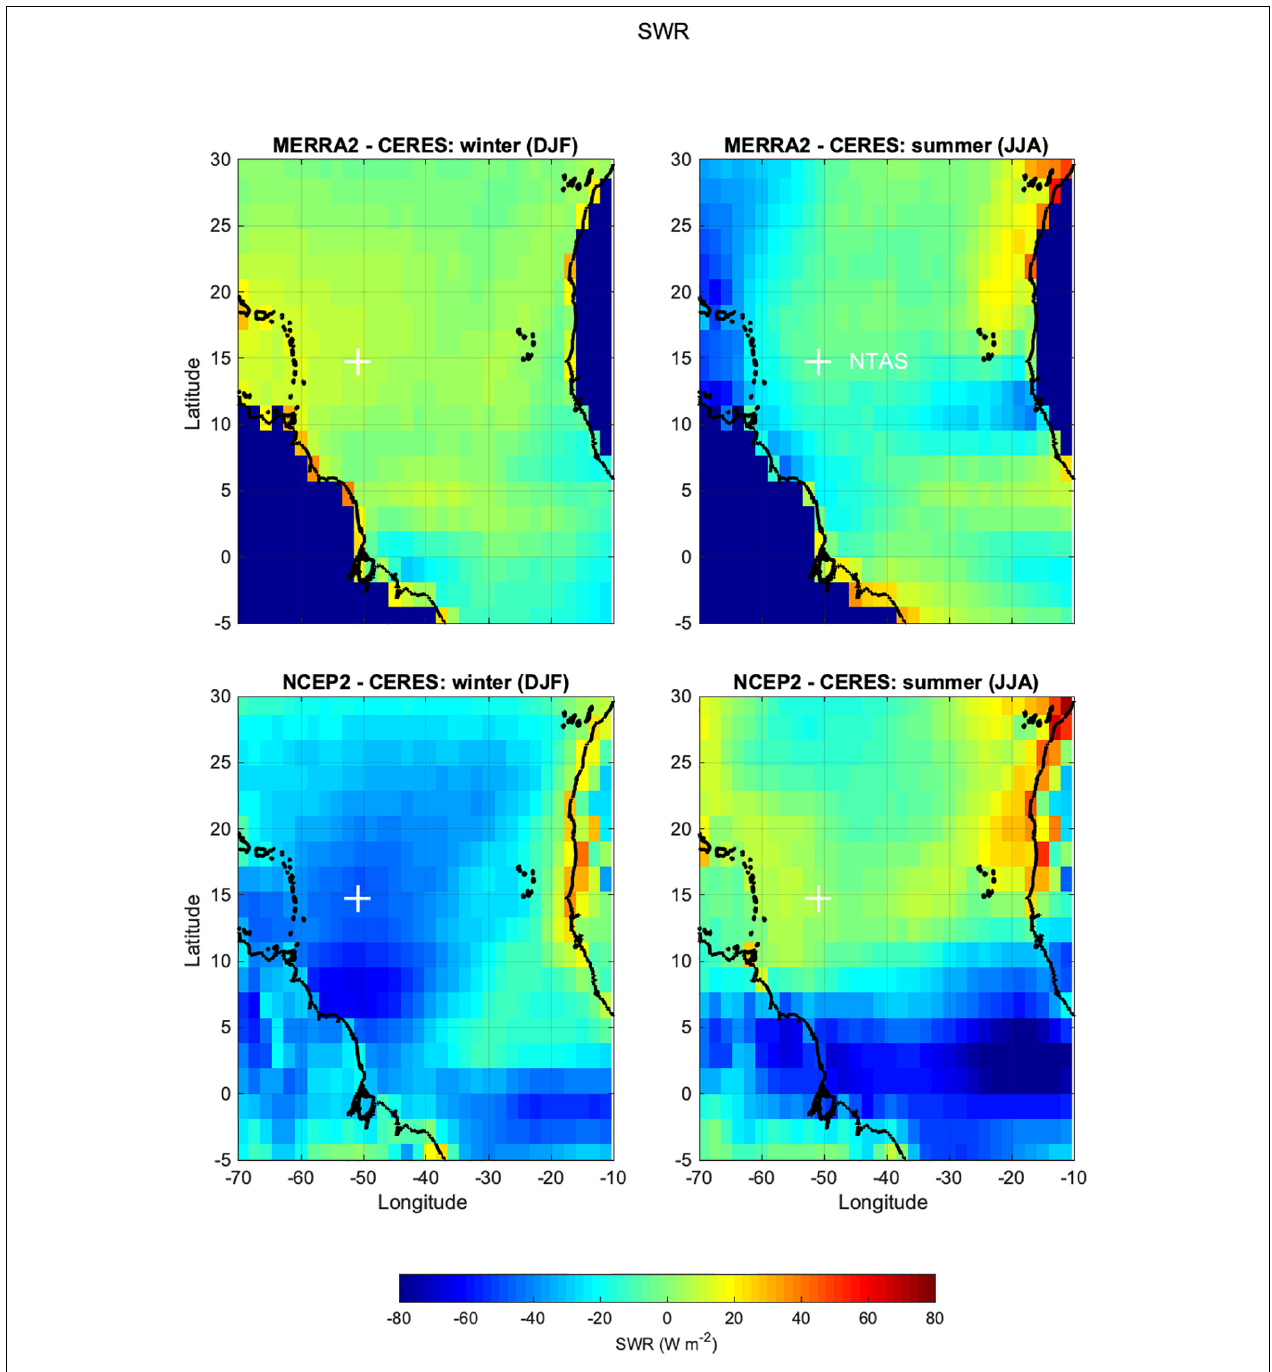
FIGURE 6 | Differences of climatological seasonal averages of shortwave radiation. Left: winter (DJF), right: summer (JJA). Top MERRA-2 minus CERES, bottom: NCEP-2 minus CERES. MERRA-2 and CERES were interpolated to the NCEP-2 spatial grid.